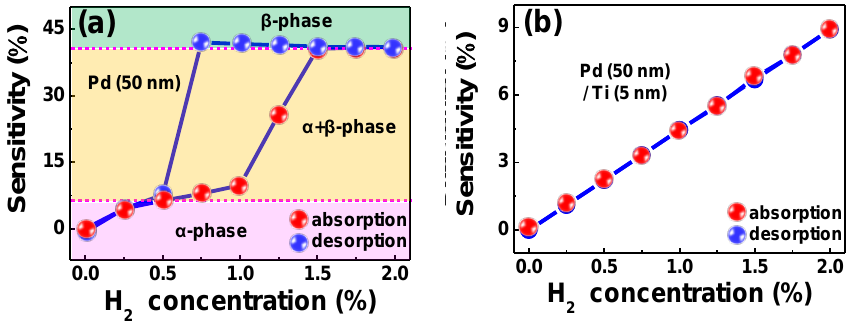
Figure 7. Sensitivity changes in (a) a pure Pd film and (b) a Ti-buffered Pd film as a function of H concentration in H absorption and desorption processes. The Pd film and Ti 2 2 buffer layer thicknesses were 50 and 5 nm. Data reproduced from Kim et al .